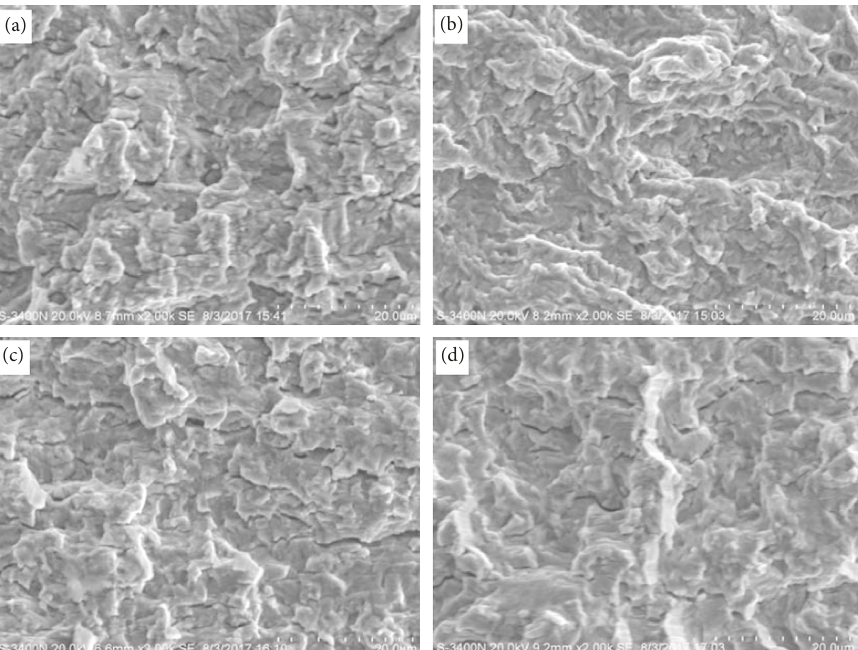
Figure 6: Typical fractures at the crack propagation zone of (a, b) the pipe bodies and (c, d) weld joints (a, c) with and (b, d) without surface finishing.